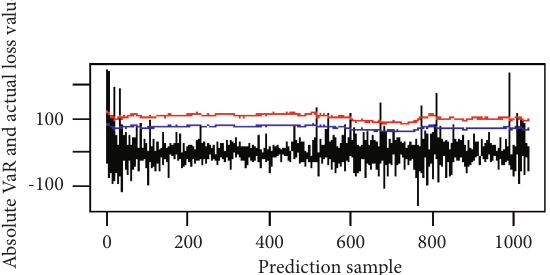
Figure 1: Comparison of absolute VaR value and actual loss under simple